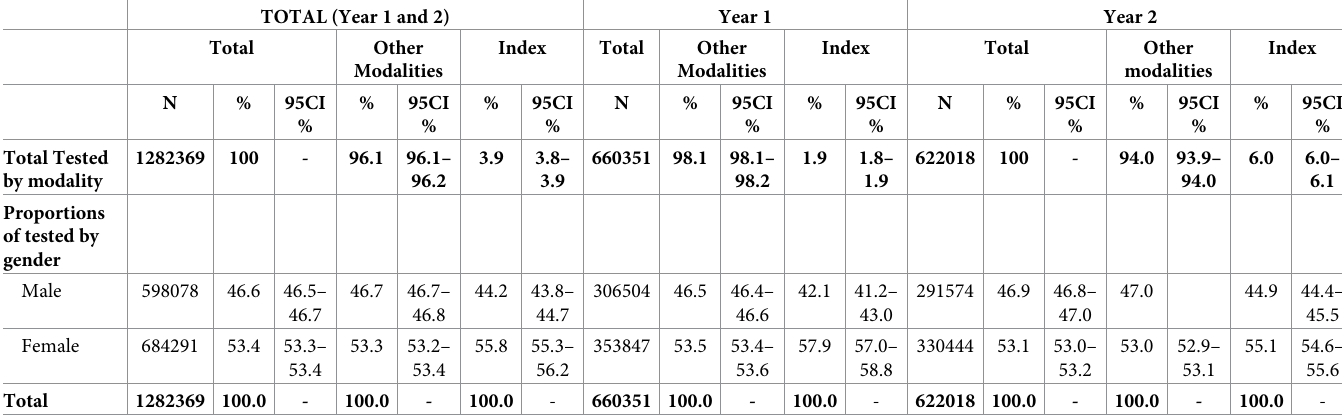
Table 2. HIV testing proportions by modality and